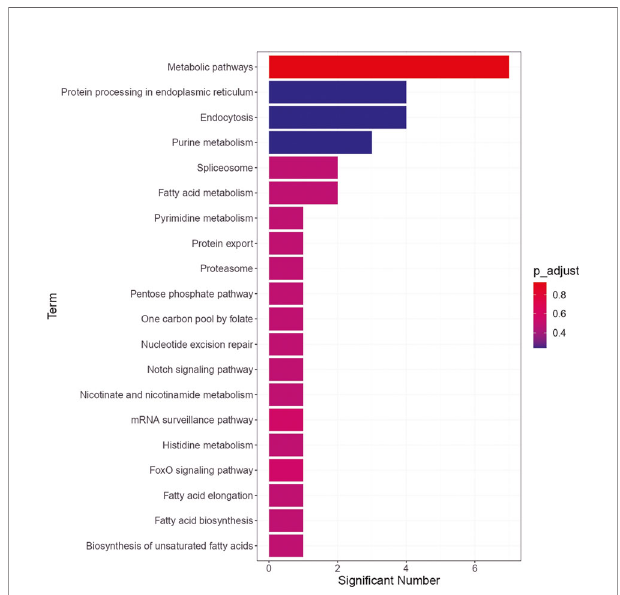
FIGURE 3 | Enriched Kyoto Encyclopaedia of Genes and Genomes (KEGG) pathways of the phosphoproteins of Haemaphysalis longicornis tick